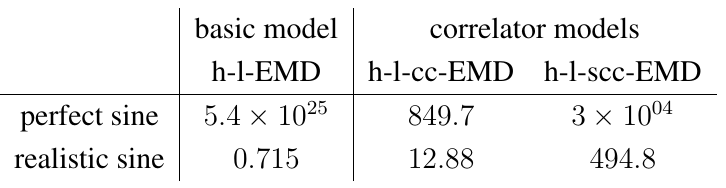
Table 1. Quality values Q for the different models (large value indicates a better discriminability of responses to different velocities). It can be seen that for the basic model the additional noise and the local intensity changes in the real sine pattern have a strong effect on the output. The (s)cc models show smaller changes in the quality of the response. The quality for the real sine pattern is much better in the (s)cc